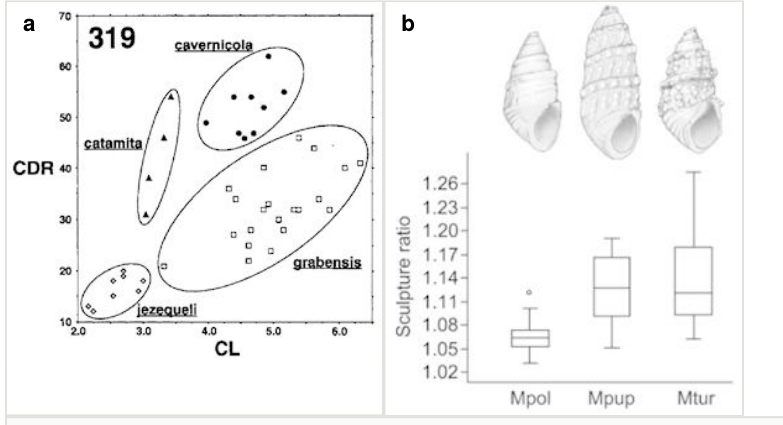
Visualizations of diagnostic morphometric characters. Quantitative characters, alone or in combination, can contribute to taxonomic identi fi cation. Values from an unknown specimen can be compared to those presented in charts such as these. a : Scatter plot of two morphometric values for four spider species (Araneae: Dipluridae: Lathrothele ), each with a distinct domain. From Coyle (1995). b : Sculpture ratio, a quanti fi cation of shell texture based on a ratio of two measurements, for three Holocene snail species (Mollusca: Gastropoda: Thiaridae: Melanoides ), from Bocxlaer and Schultheiß